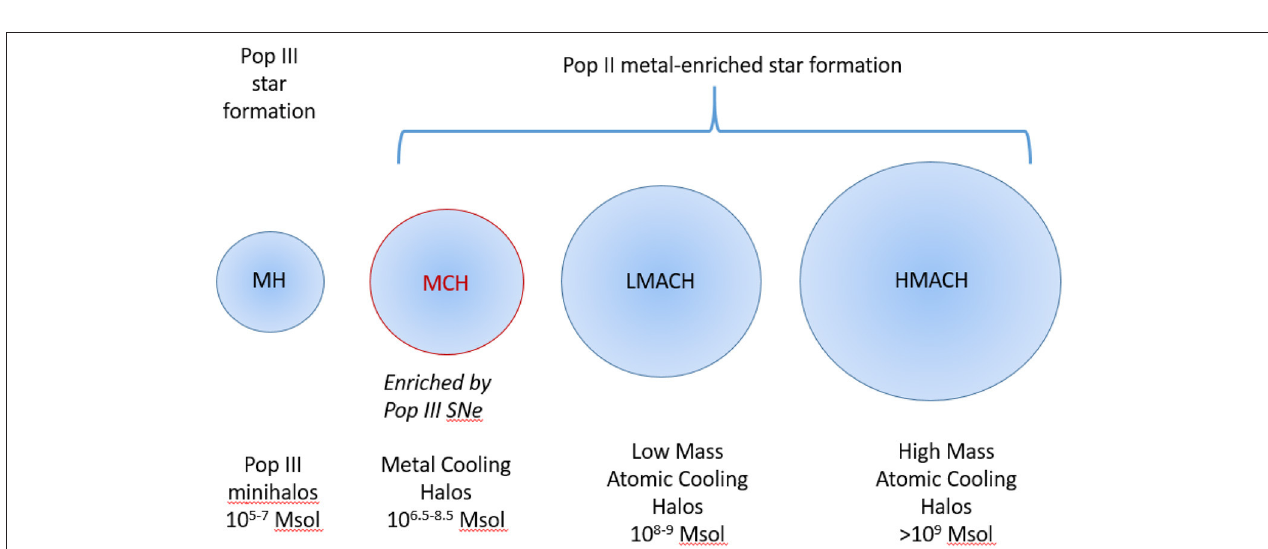
FIGURE 6 | Recipe for making a numerical star or star cluster used in Enzo for Cosmic Dawn simulations. Based on description in Wise et al. (2012b).